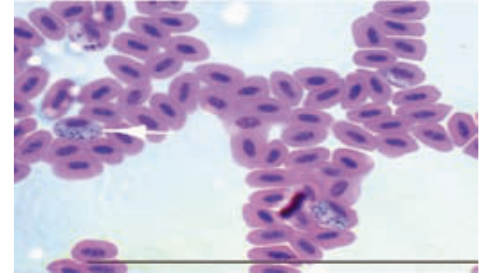
Fig.1 . Gamonts of Haemoproteus in